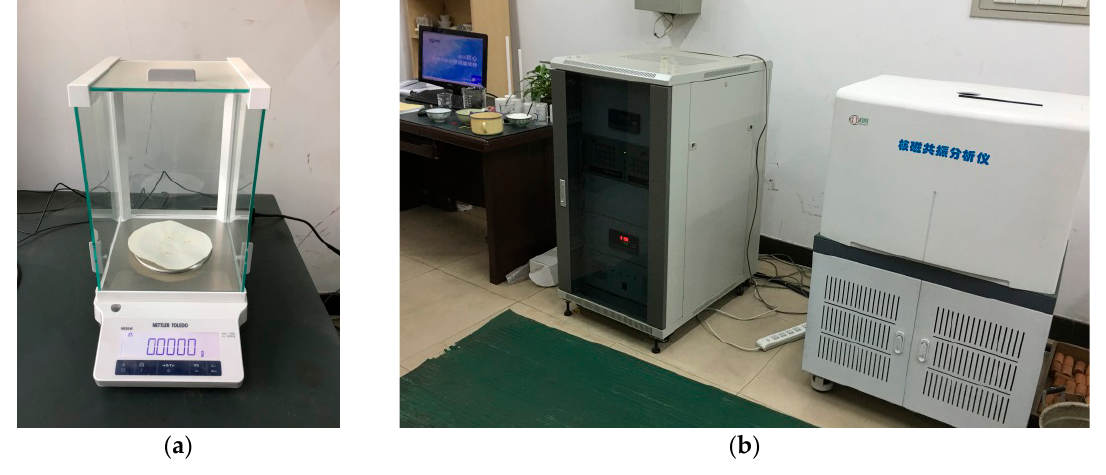
Figure 1. The apparatus for water imbibition experiment: ( a ) analytical balance, ( b ) NMR device (MiniMR-VTP).